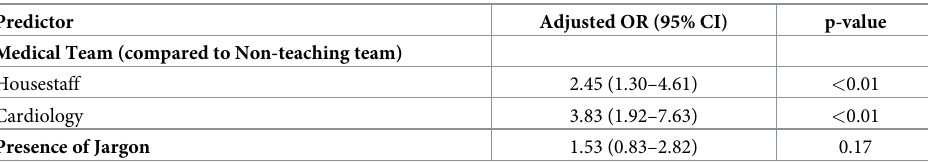
Table 3. Association of jargon and medical team with completely understanding diagnosis (n =